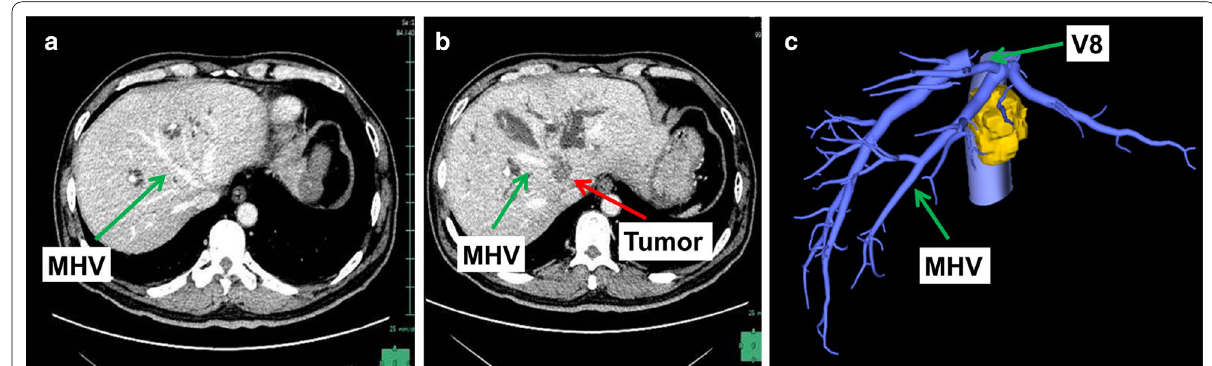
Fig. 3 Relationship between tumor and hepatic veins: a and b are CT scan which shows that the tumor infiltrated the root of the middle hepatic vein, and the left hepatic vein was not infiltrated. c The three-dimensional reconstruction of the tumor and hepatic vein. MHV middle hepatic vein, V8 hepatic vein of segment 8